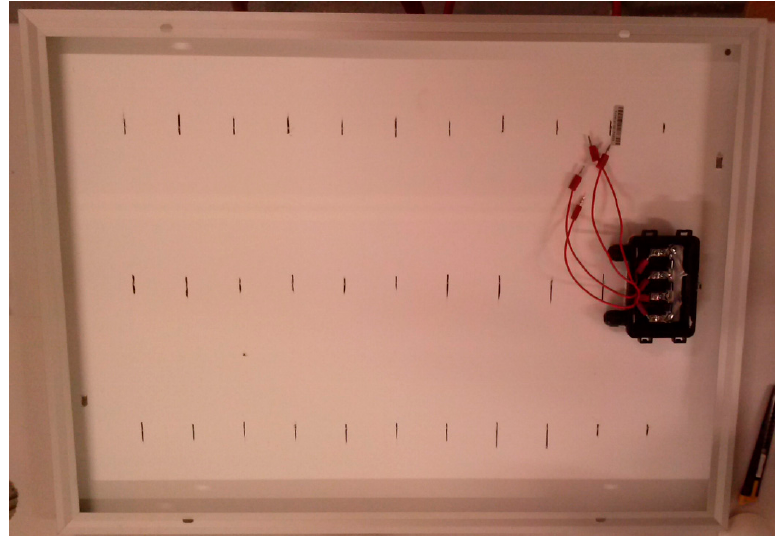
Figure 5. Incisions in the rear of the module.